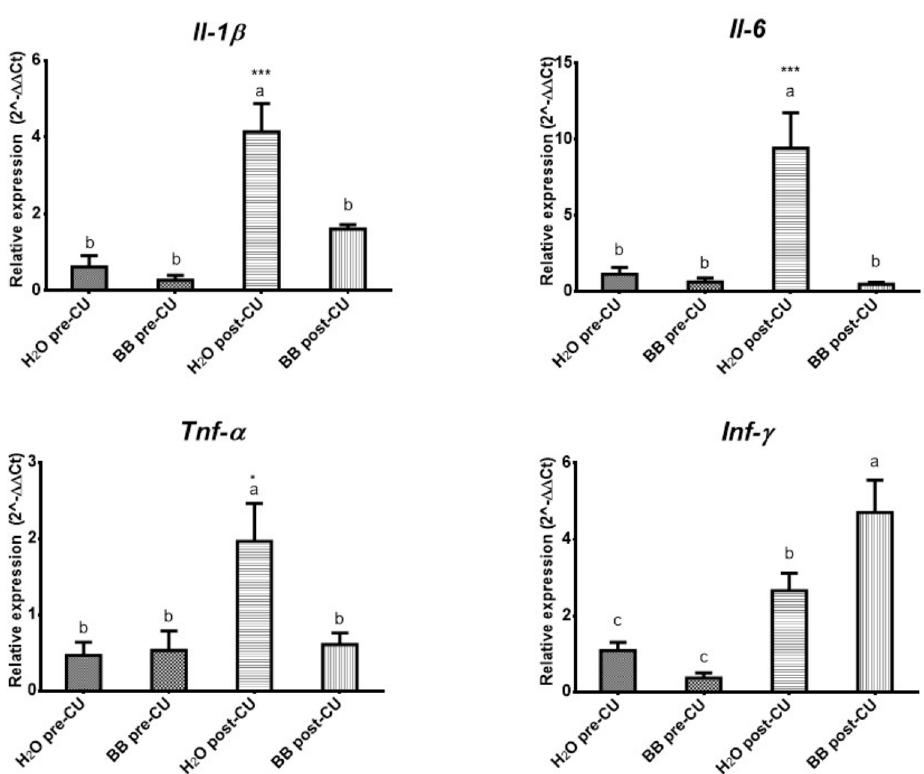
Figure 3. Evaluation of the expression of pro-inflammatory cytokines (2ˆ- ∆∆ Ct). The data is presented as the mean of each group, the bars indicate the standard error, the letters on each column indicate the statistical differences. * p ≤ 0.05, *** p ≤